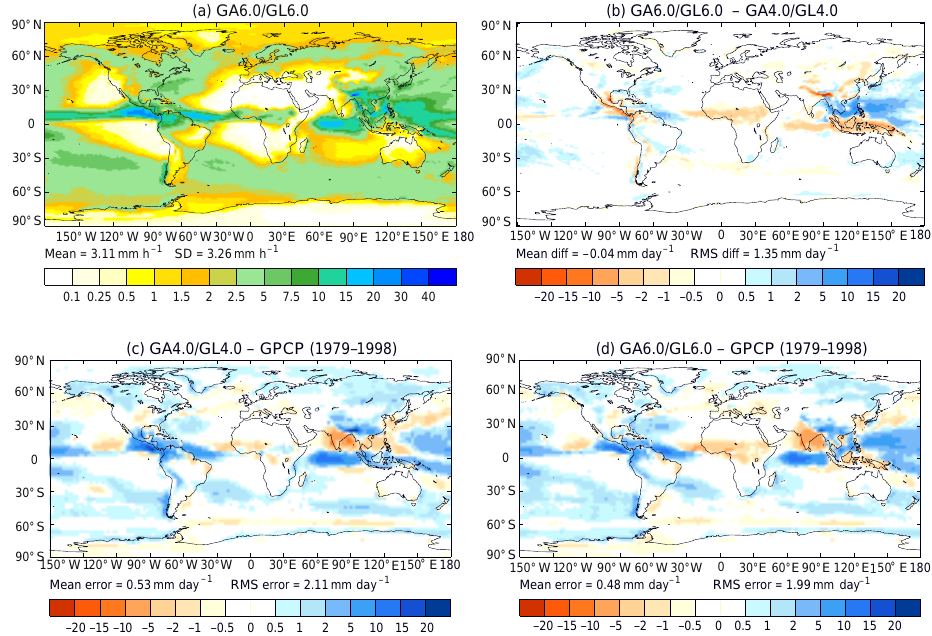
Figure 14. JJA precipitation rate (mmday − 1 ) in an N96 atmosphere/land-only climate simulation using GA6.0 (a) , the difference from GA4.0 (b) and the bias against GPCP (Global Precipitation Climatology Project; Adler et al., 2003) for GA4.0 (c) and GA6.0 (d)